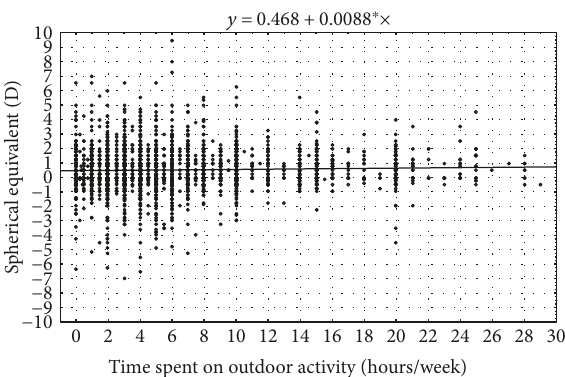
Figure 4: Mean spherical equivalent in relation to outdoor